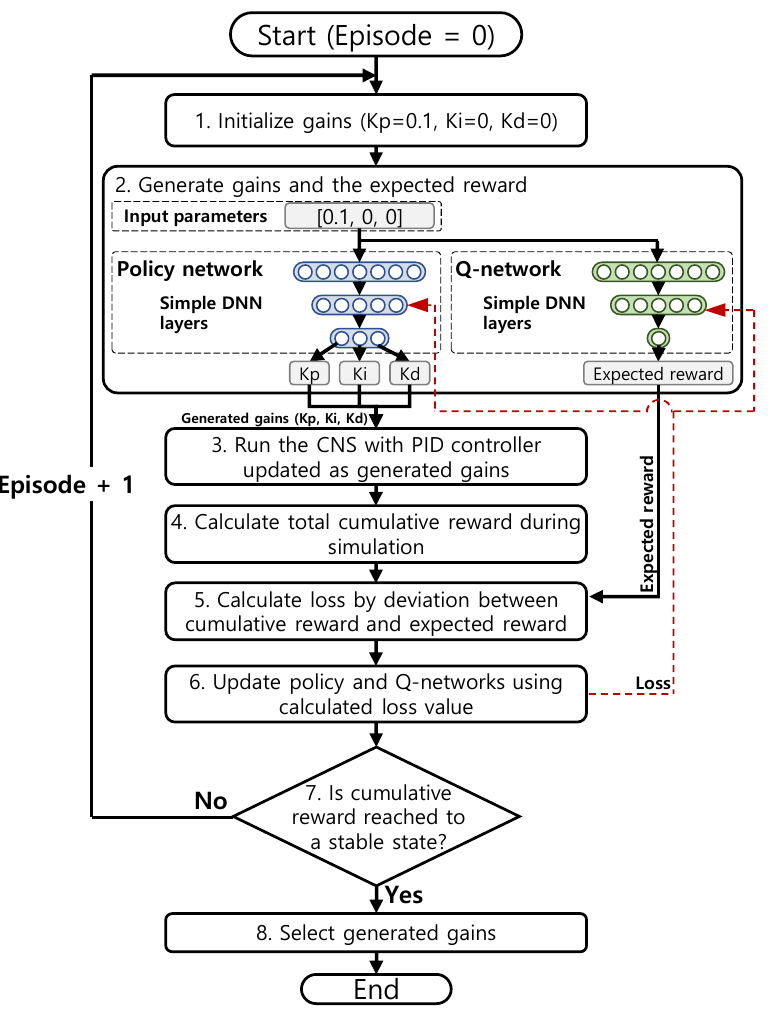
Figure 17. Flowchart of the DRL tuning algorithm.